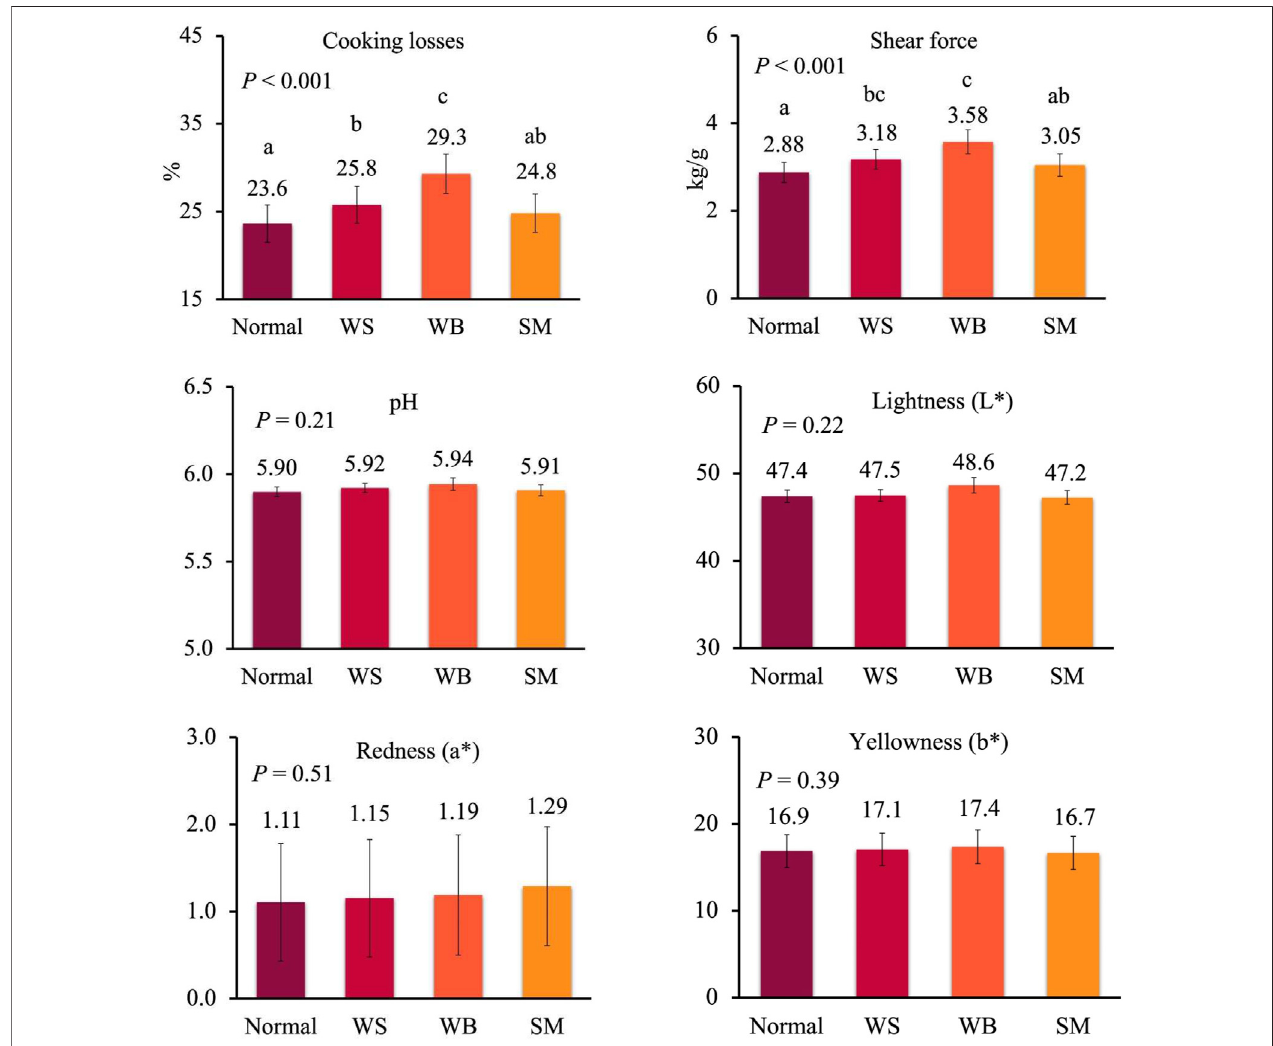
FIGURE 2 | Meat quality in normal breasts and in breasts affected by wooden breast (WB), white striping (WS) and spaghetti meat (SM) of female broiler chickens (samples with only one myopathy). Data are presented as LS means ± standard error. Different letters above bars indicate signi fi cant differences between LS means. [Number of chickens per group available in Supplementary Table S2